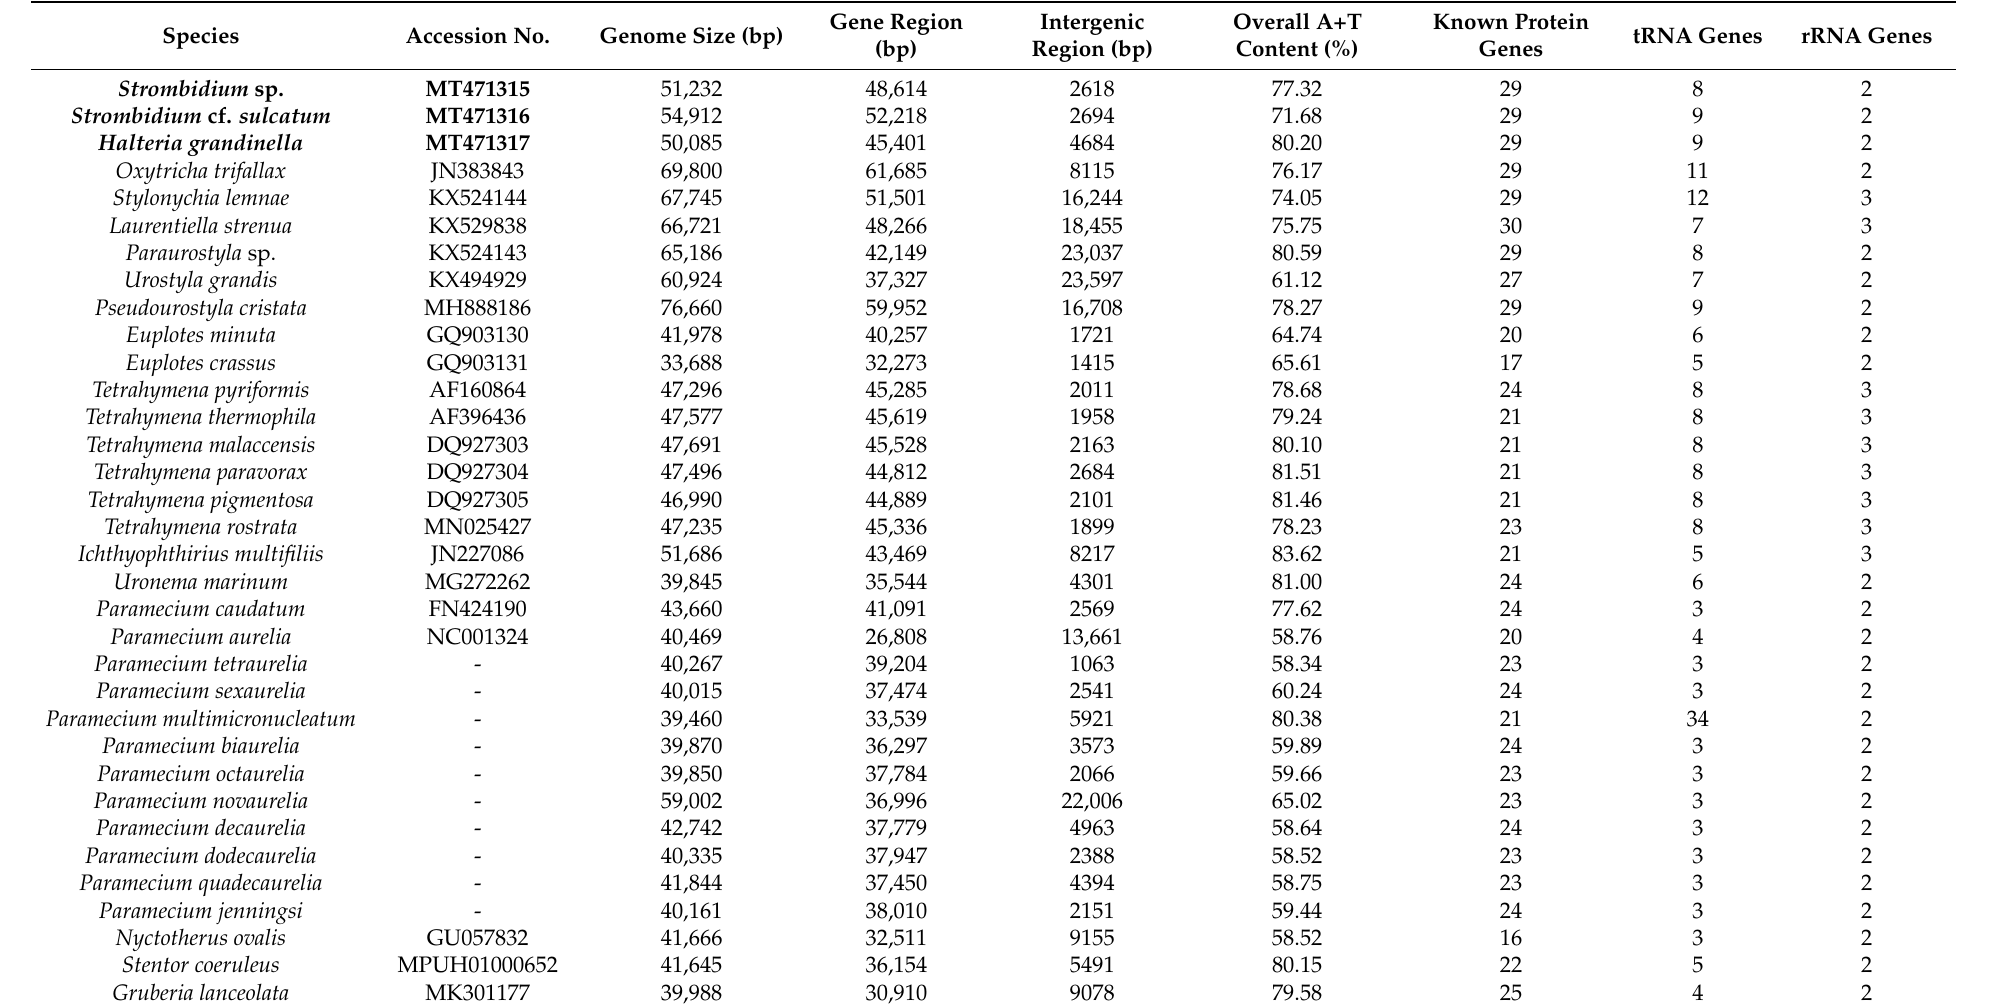
Gene Region Intergenic (bp) Region (bp) Content (%)